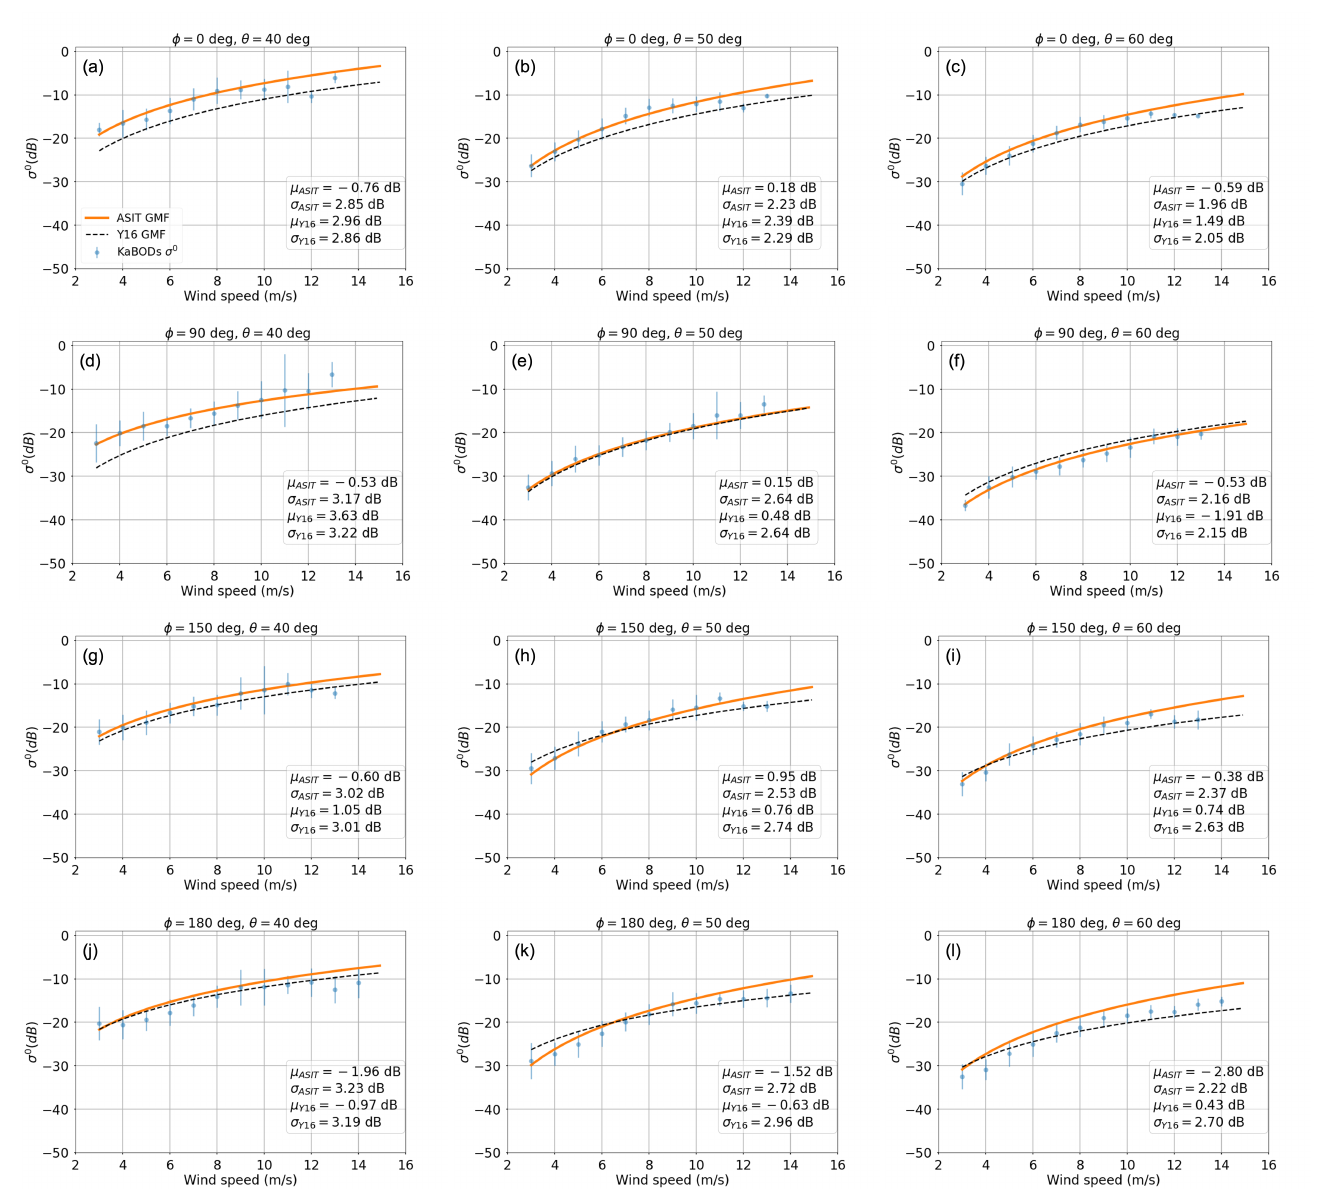
Figure 6. Ka-band sea surface backscattering coefficient for relative wind direction φ = 0 ◦ ( a – c ), φ = 90 ◦ ( d – f ), φ = 150 ◦ ( g – i ) and φ = 180 ◦ ( j – l ), at three different incidence angles, 40 ◦ ( left ), 50 ◦ ( middle ) and 60 ◦ ( right ). The comparison amongst the KaBODS observations averaged over 1-m/s-bin (dots), the ASIT GMF (solid line) and the KaDPMod GMF from Yurovsky et al. (dashed line) is